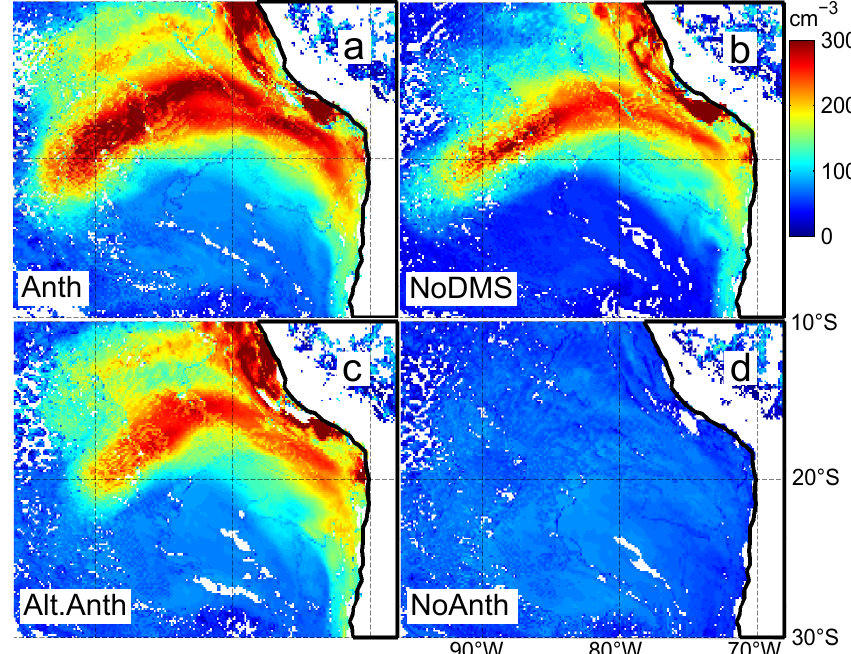
Fig. 9. Snapshots of N d on 19 October at 03:00UTC from different simulations: (a) Anth, full anthropogenic emissions, includes DMS; (b) NoDMS, full anthropogenic emissions, no DMS; (c) Alternative Anth: no anthropogenic emissions south of 30 ◦ S, east of 70 ◦ W, includes DMS; (d) NoAnth, no anthropogenic emissions, includes DMS.